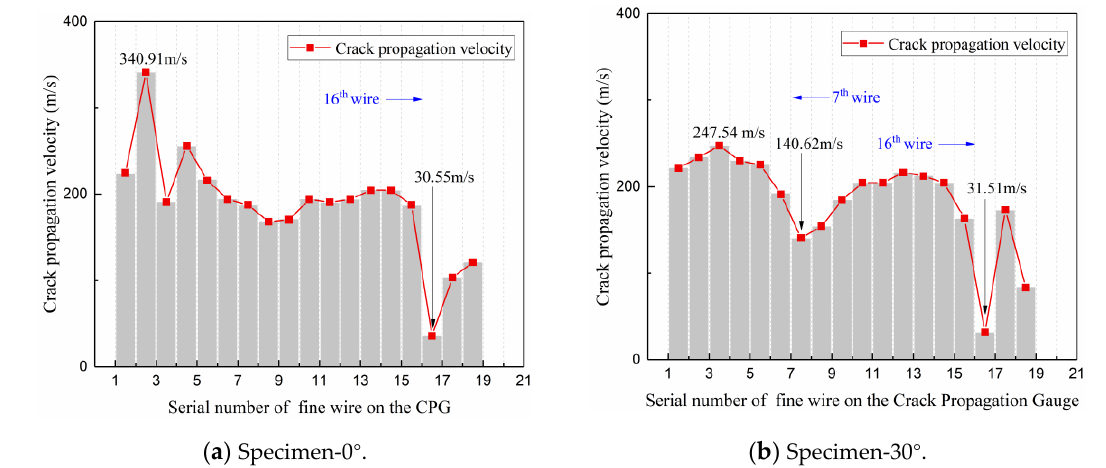
Figure 7. Crack propagation velocity curves of specimens. ( a ) specimen-0 ° . ( b ) specimen-30 ° .